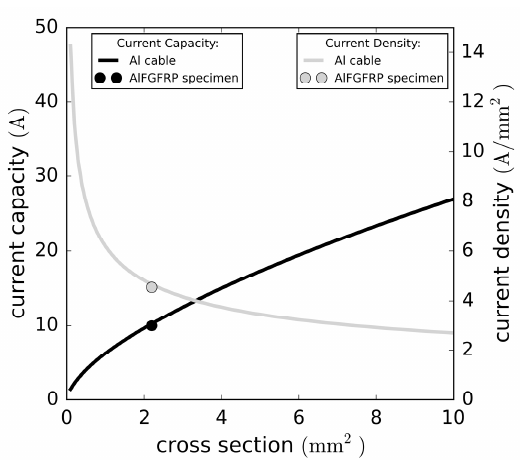
Figure 29. Current ratings of conventional single-core aluminum cables based on [46], with data points below 4 mm 2 resulting from extrapolation: comparison with the current load of the aluminum phase of the AlFGFRP-material.